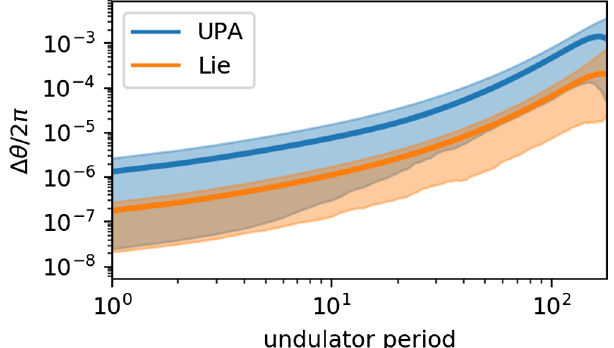
FIG. 1. Comparison of particle pushers derived from Lie map and conventional WPA. The error is defined by Δ θ ≡ j θ − θ where θ is from a converging small enough step size integration ref of exact Hamiltonian and the two θ (blue and orange) are from the 4th order RK tracking of the conventional WPA and the generalized WPA. Exponentially growing Gaussian field envelope from 0.4 MW to 1 GW in power, σ r ¼ 56 μ m and λ r ¼ 27 nm is assumed. Electron beam parameters used are σ 56 μ m, ϵ 0 . 6 μ m, γ ¼ 1000 and Δ γ = γ ¼ 2 × 10 − 4 . x;y ¼ x;y ¼ wiggler parameters used are K ¼ 1 . 5 , λ u ¼ 2 . 5 cm, and ffiffiffi p k k k = 2 . The thick line represents the ensemble aver- x ¼ y ¼ u age and the shadowed area corresponds to the range of error of simulated particles ’